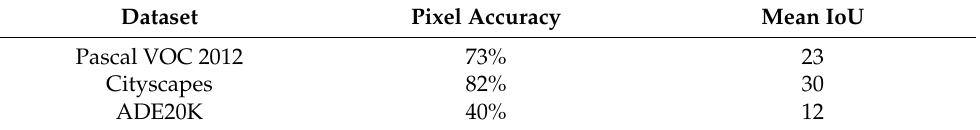
Table 5. Results of the architecture with transfer learning applied on the three